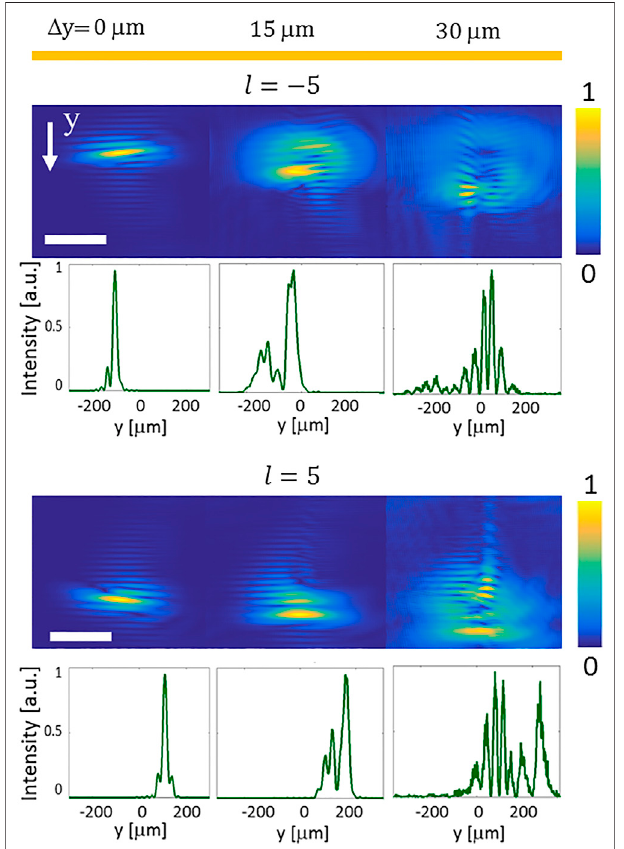
FIGURE 8 | Intensity pro fi les of the l (cid:2) ± 5 modes on the detector when displacements on y -axis are added. The OAM spectrum is analyzed for each case. The OAM spectrum is obtained by line scanning the obtained modes in the y -axis of the intensity distribution picture. Scale bars, 60 μ m.